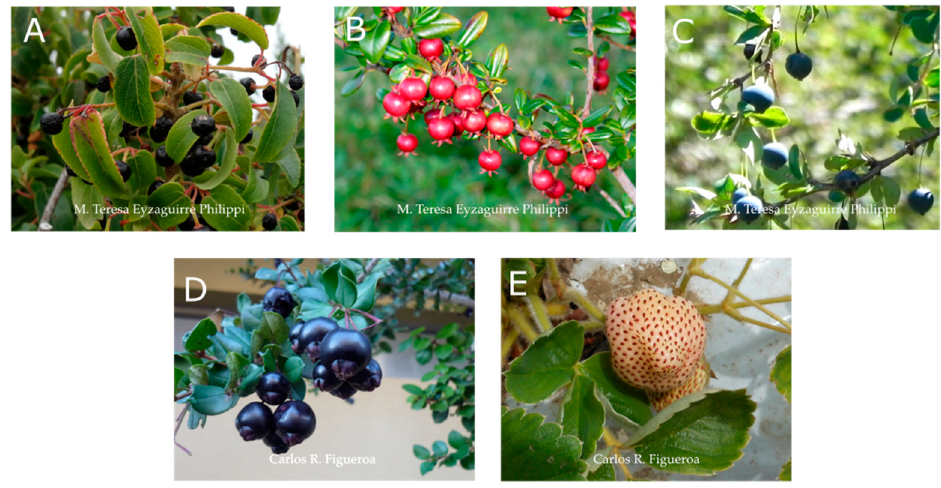
Figure 1. Patagonian berries with healthy potential as a functional food on the basis of recent research data available. ( A ) Aristotelia chilensis (Mol.) Stuntz (maqui)*; ( B ) Ugni molinae Turcz. (murta)*; ( C ) Berberis microphylla G. Forst. (calafate)*; ( D ) Luma apiculata (DC.) Burret (arrayan)**; ( E ) Fragaria chiloensis (L.) Mill. (Chilean strawberry)**. Photography credit to M. Teresa Eyzaguirre-Philippi (*) and Carlos R. Figueroa (**).